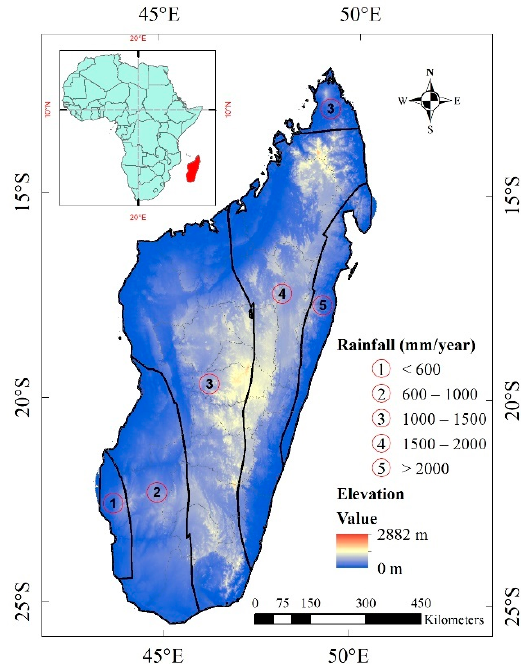
Figure 1. Elevation and rainfall map of Madagascar data obtained from Madagascar meteorological and hydrological service and USGS-NASA.